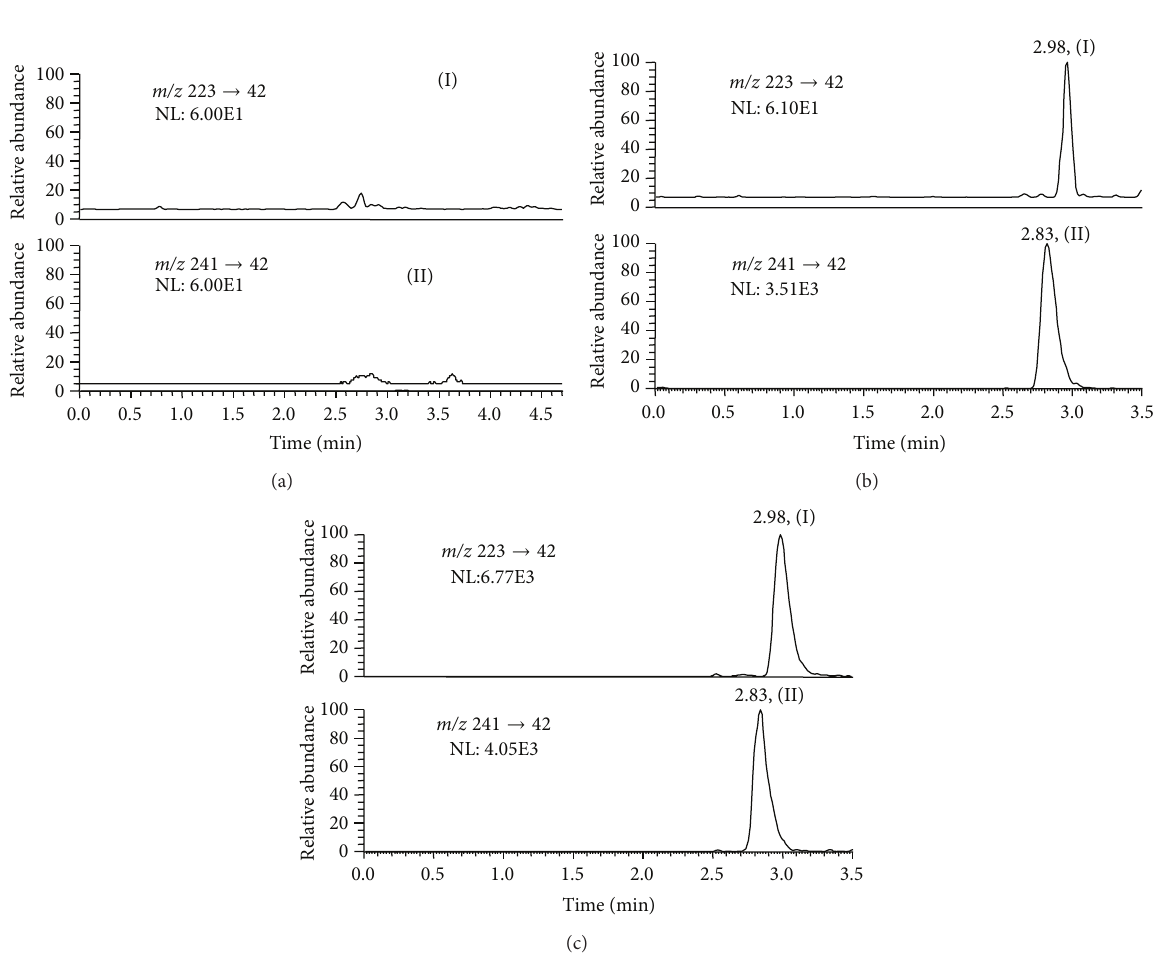
Figure2:Representativeselectedreactionmonitoringchromatogramsofstavudine(I)andtheinternalstandard(II).(a)Blankplasmasample; (b) plasma sample spiked with stavudine (LLOQ, 5.00 ng/mL) and internal standard (400 ng/mL); (c) plasma sample from a volunteer 0.75 h after an oral dose of 20mg